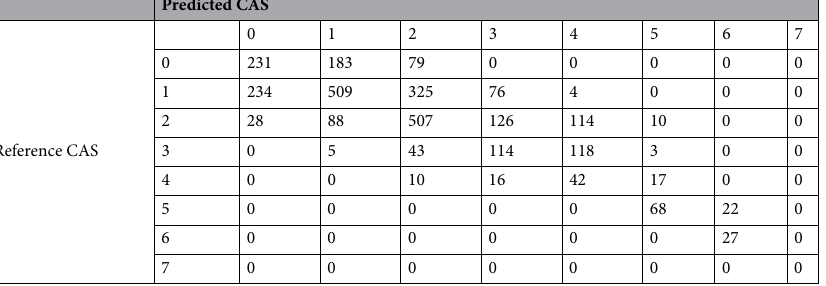
Table 5. Prediction of the CAS by the ML-assisted system using the test set constructed from the dataset with consistent results. All of 3,000 test results from 30 repeated experiments were presented. The predicted CAS was generated using the ML-assisted system, and the reference CAS was evaluated by three ophthalmologists using the patients’ facial images. CAS clinical activity score, ML machine